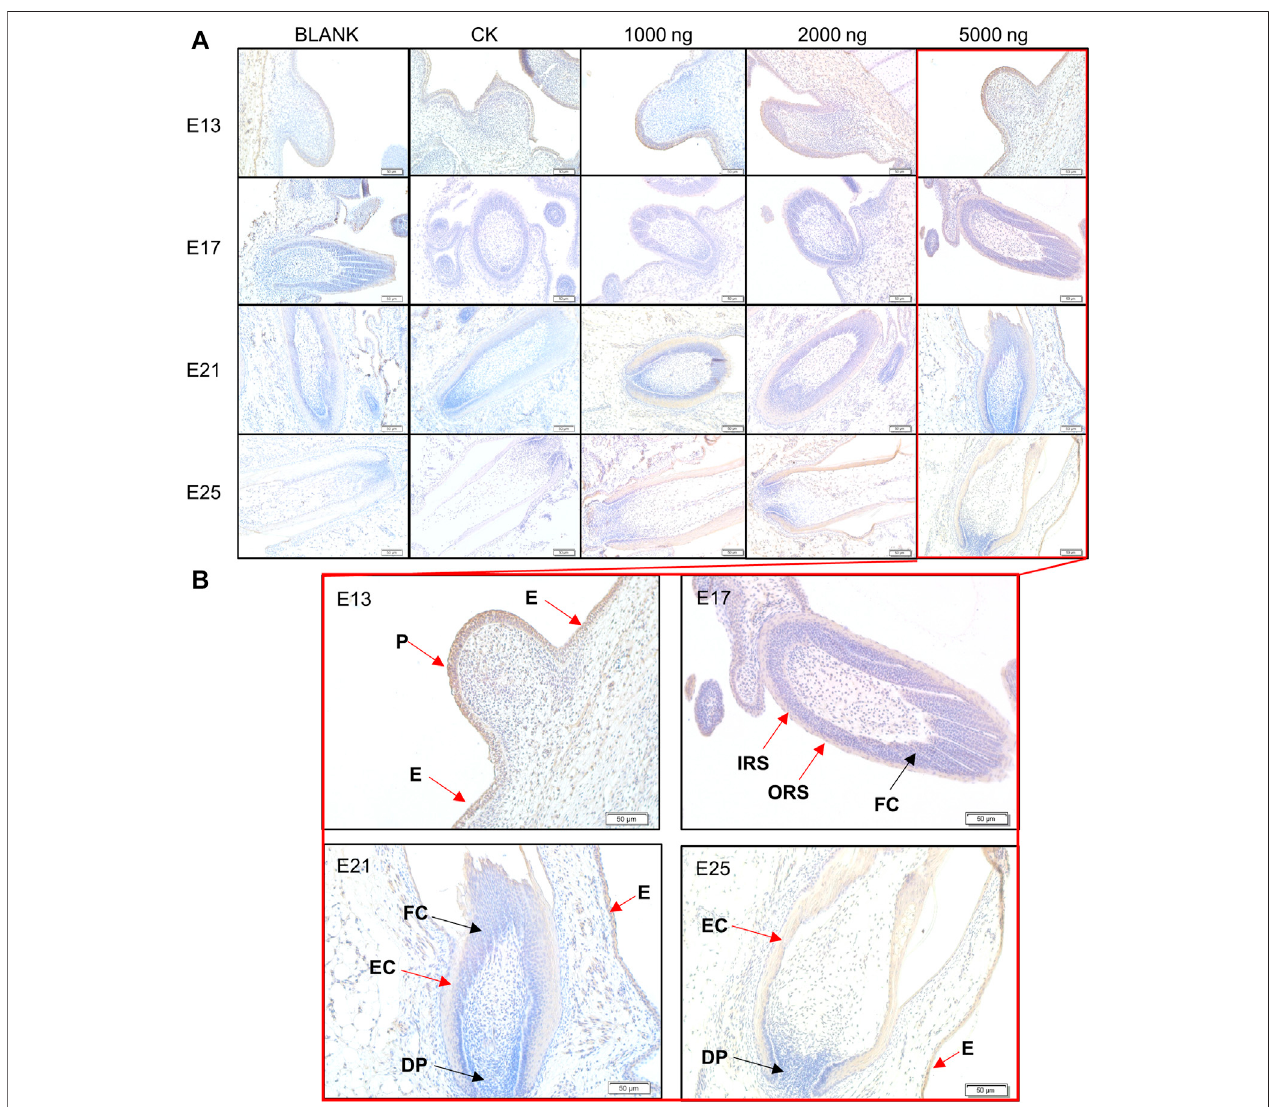
FIGURE 6 | (A) Representative images of distribution of beta-catenin in feather follicles as detected by IHC-P. (B) The main positive expression area of β -catenin. Black arrows: negative express, red arrows: positive express. P, Placode; DP, Dermal papilla; E, Epidermis; EC, Epidermal collar; FC, Feather crest; IRS, Inner root sheath; ORS, Outer root sheath. Bar = 50 μ